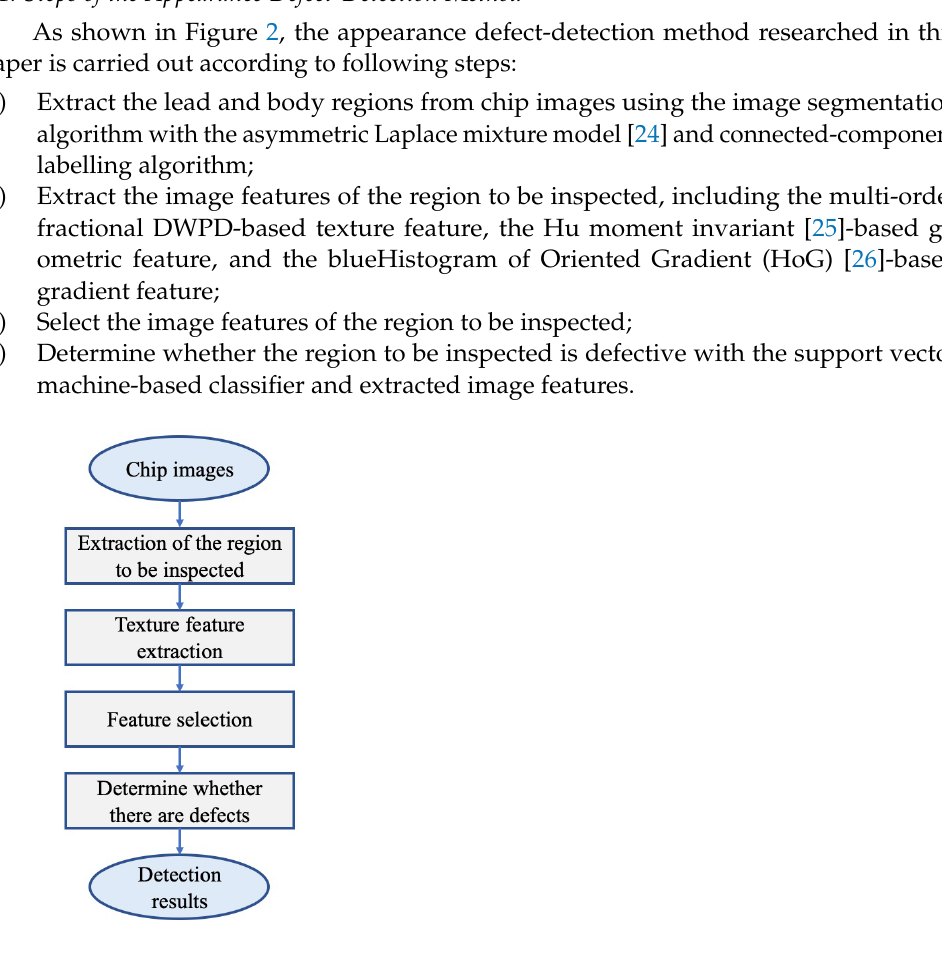
Figure 2. Flowchart of the proposed